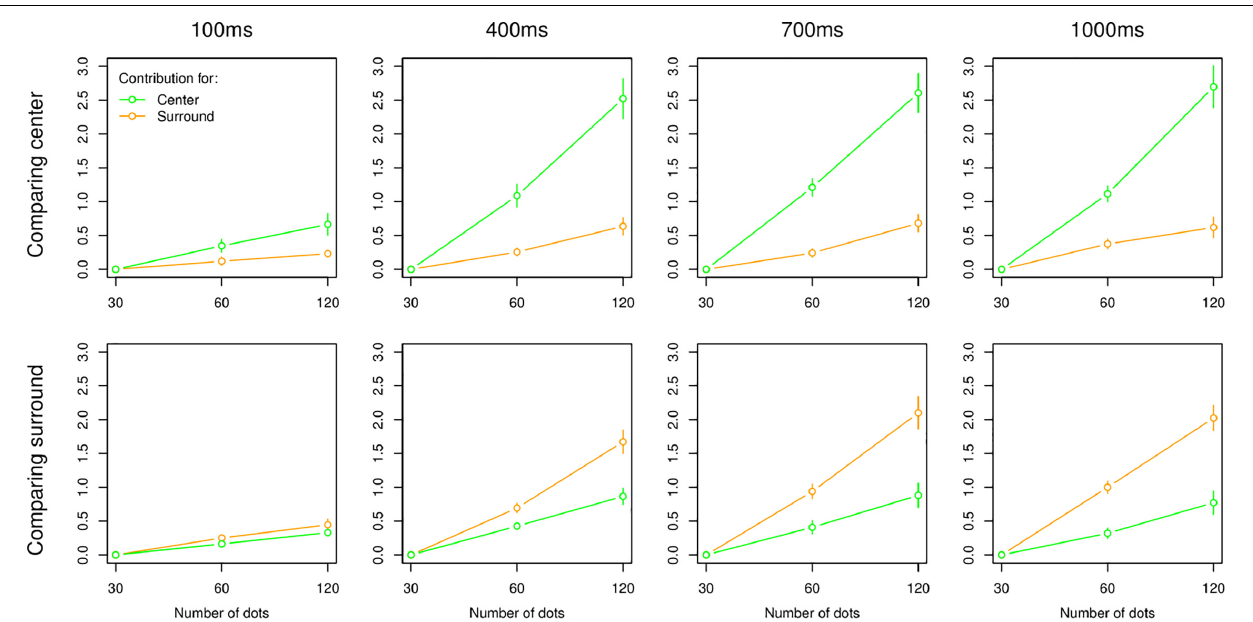
FIGURE 3 | Results of MLCM analysis (additive model). Average contributions to the perceived numerosity in centre (green) and surround (orange) as a function of 30, 60, and 120 dots. Plots are organized by task (i.e., top panel: centre task, bottom panel: surround task) and presentation intervals (columns). All error bars are standard error of the